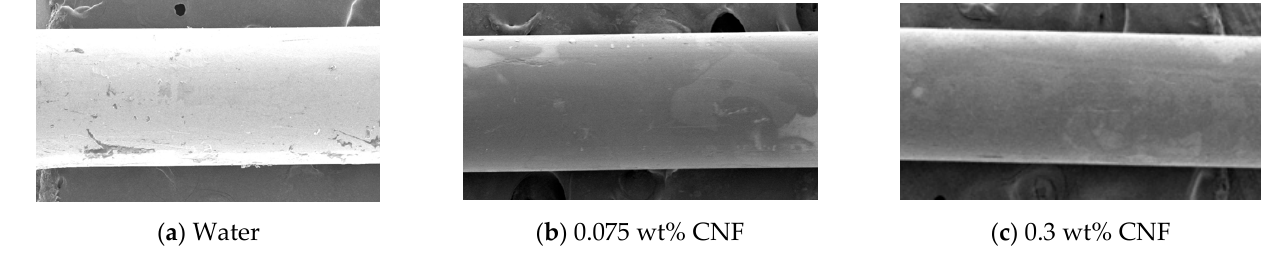
Figure 1. Scanning electron microscopy (SEM) image of wire after the experiment.